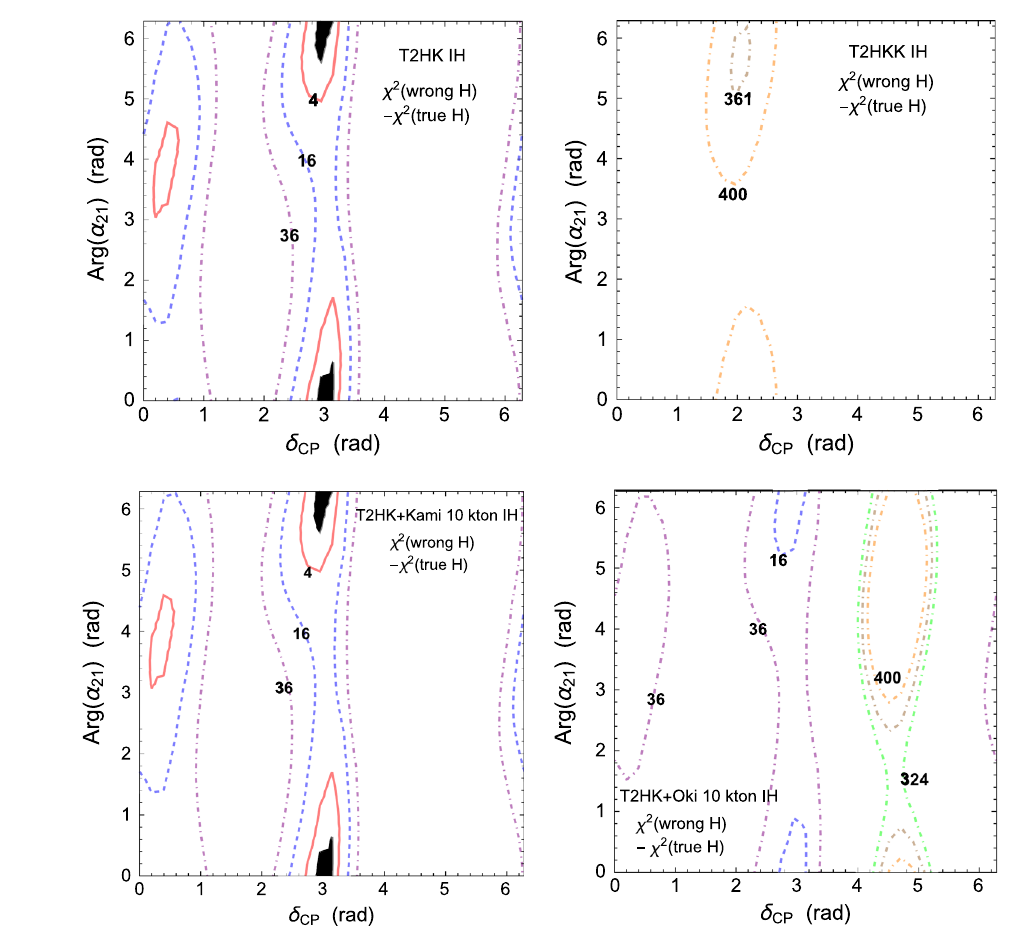
Fig. 5 The difference between the minima (with respect to δ CP only) of χ 2 ((cid:20)) for the wrong and true mass hierarchy, { min χ 2 ( wrong H ) − min χ 2 ( true H ) } , which is the square of the significance of rejecting the wrong hierarchy. The benchmark with Eq. (26) is assumed, and the true mass hierarchy is inverted. The upper-left, upper-right and lower-right subplots correspond to the T2HK, the T2HKK, and the plan of the T2HK plus a 10 kton water Cerenkov detector at Oki, respectively. For comparative study, we show in the lower-left a sub-